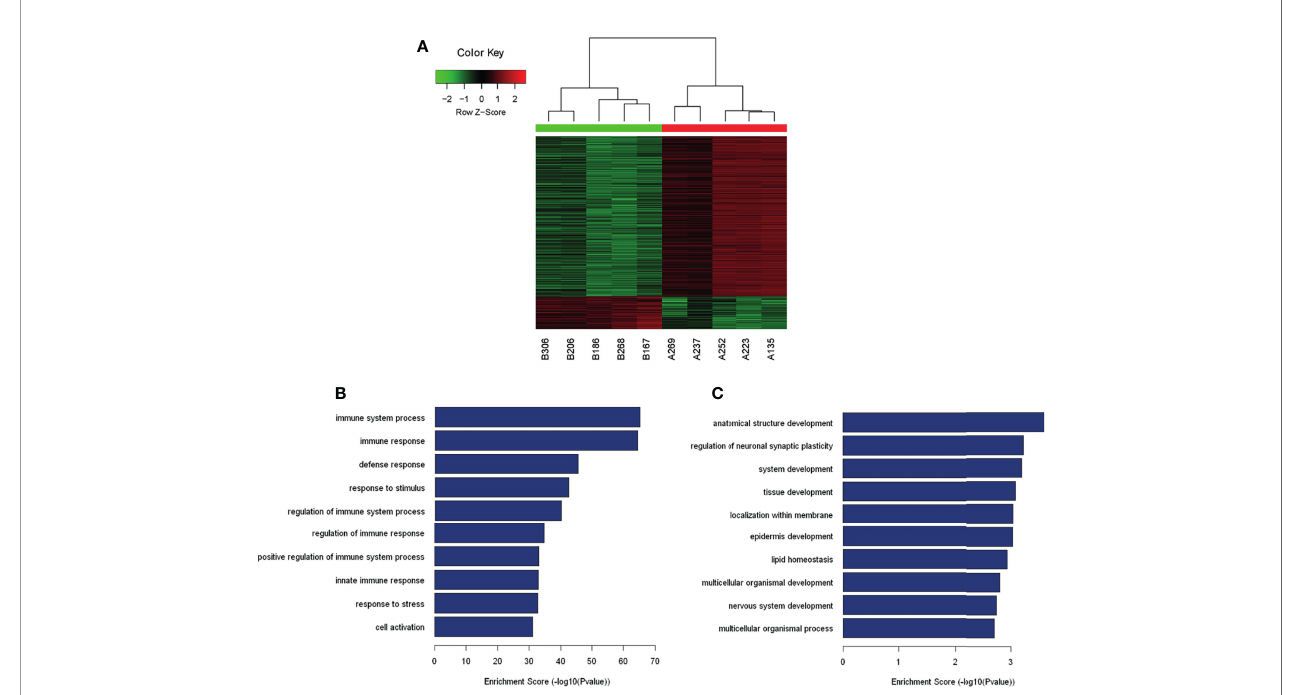
FIGURE 2 | Heat maps showing the differential expression and hierarchical clustering of mRNAs (A) . The top10 up-regulated and down-regulated pathways are presented (B, C)